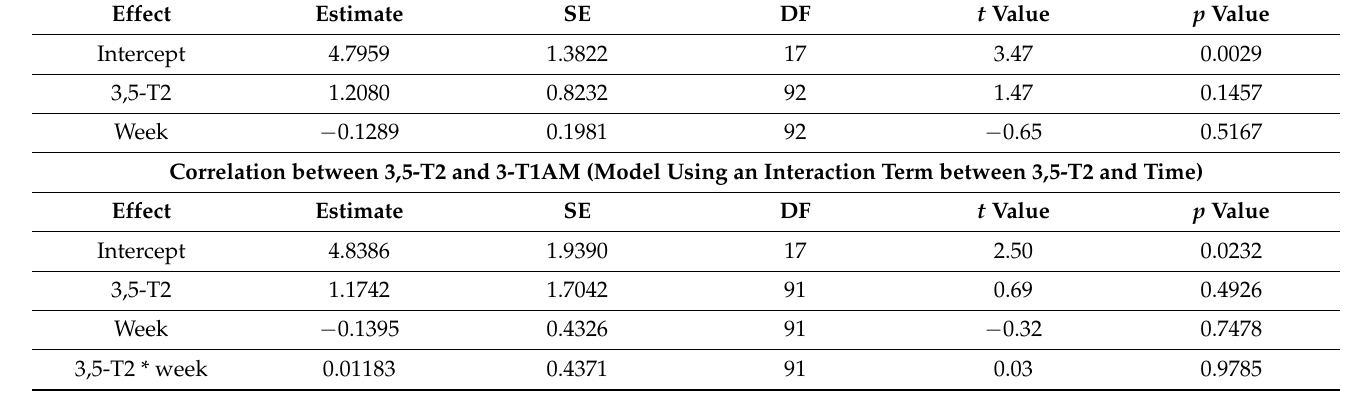
Table 5. Correlations between 3,5-T2 and T1AM concentrations during the hourly sampling in the patients with hypothyroidism. (* = interaction